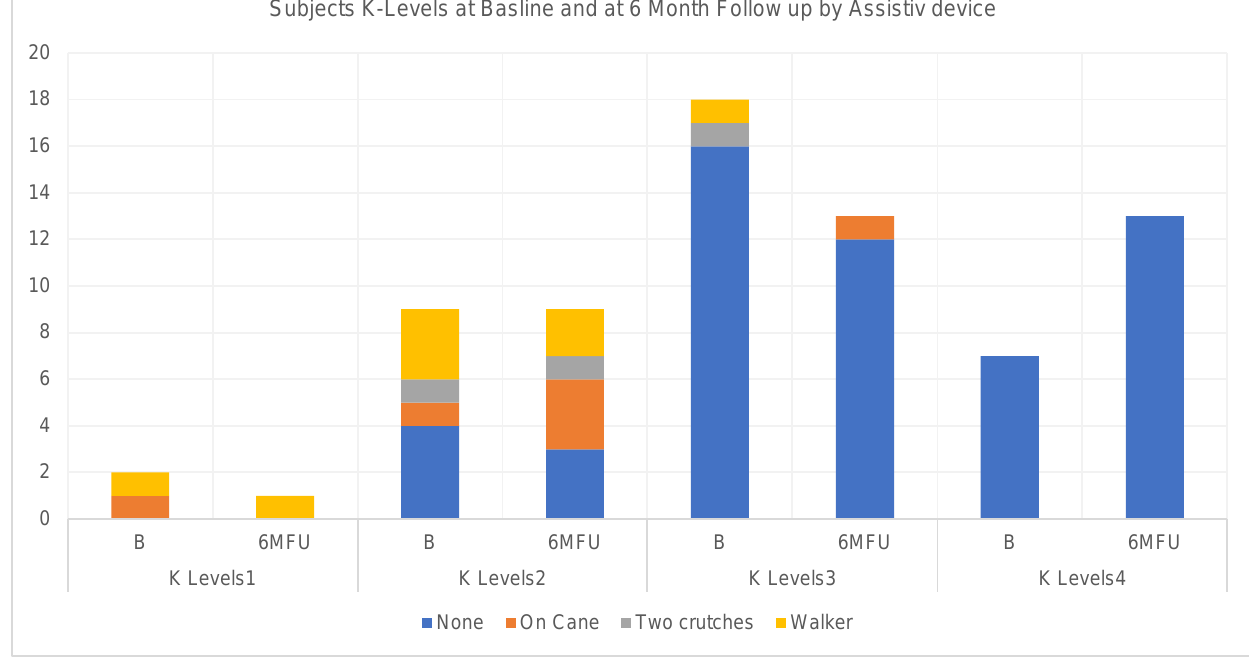
Figure 4: Changes from Baseline to 6MFU in K Levels using the AMPPRO Score, and assistive device use.